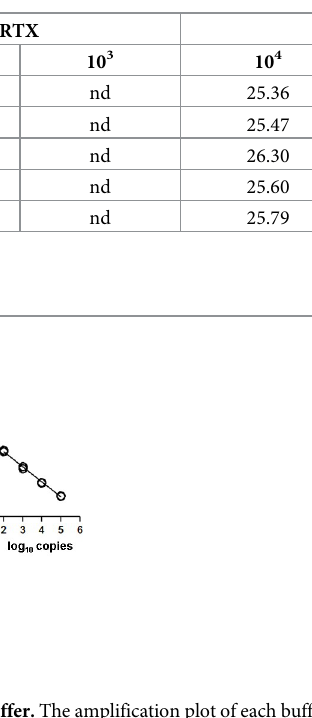
Table 2. The Ct value of the one-step real-time PCR with MM4 and K4pol L329A , RTX, or M1pol Tth .